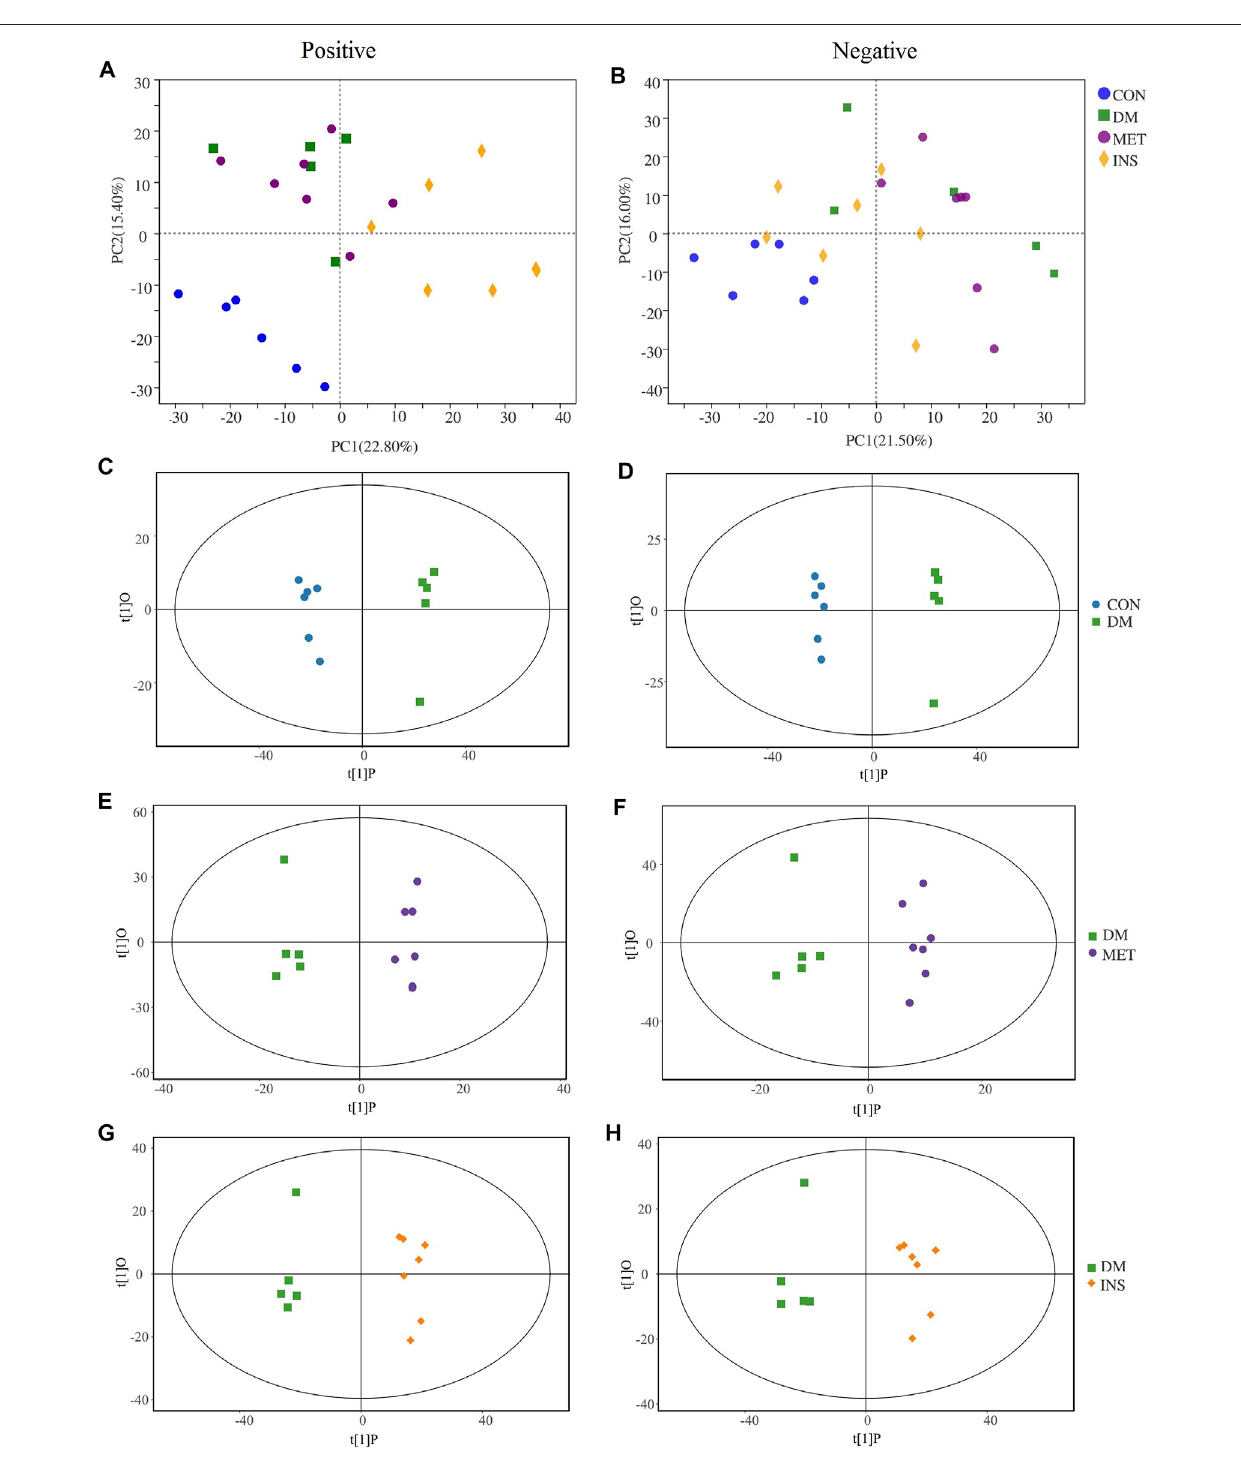
FIGURE4| PCAandOPLS-DAscoreplotsinpositivemodeandnegativemode.PCAscoreplotofeachgroupinpositivemode (A) andnegativemode (B) .OPLS- DA score plots from CON group vs DM group in positive mode (C) and negative mode (D) ; MET group vs DM group in positive mode (E) and negative mode (F) ; INS group vs DM group in positive mode (G) and negative mode (H) .